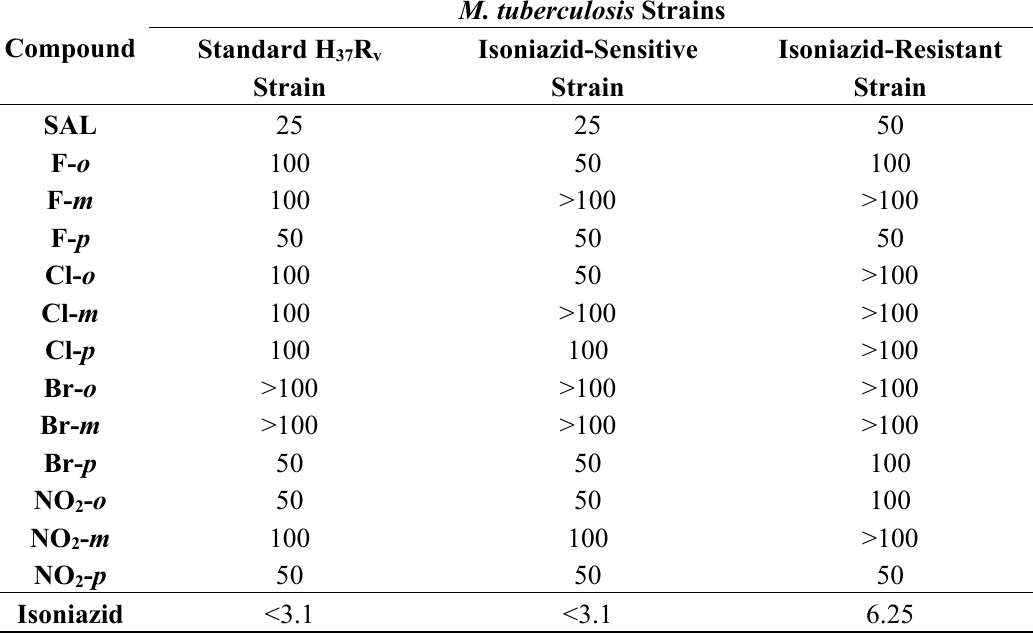
Table 7. Antitubercular activity of SAL and its N- benzyl amides. Data are given as MIC